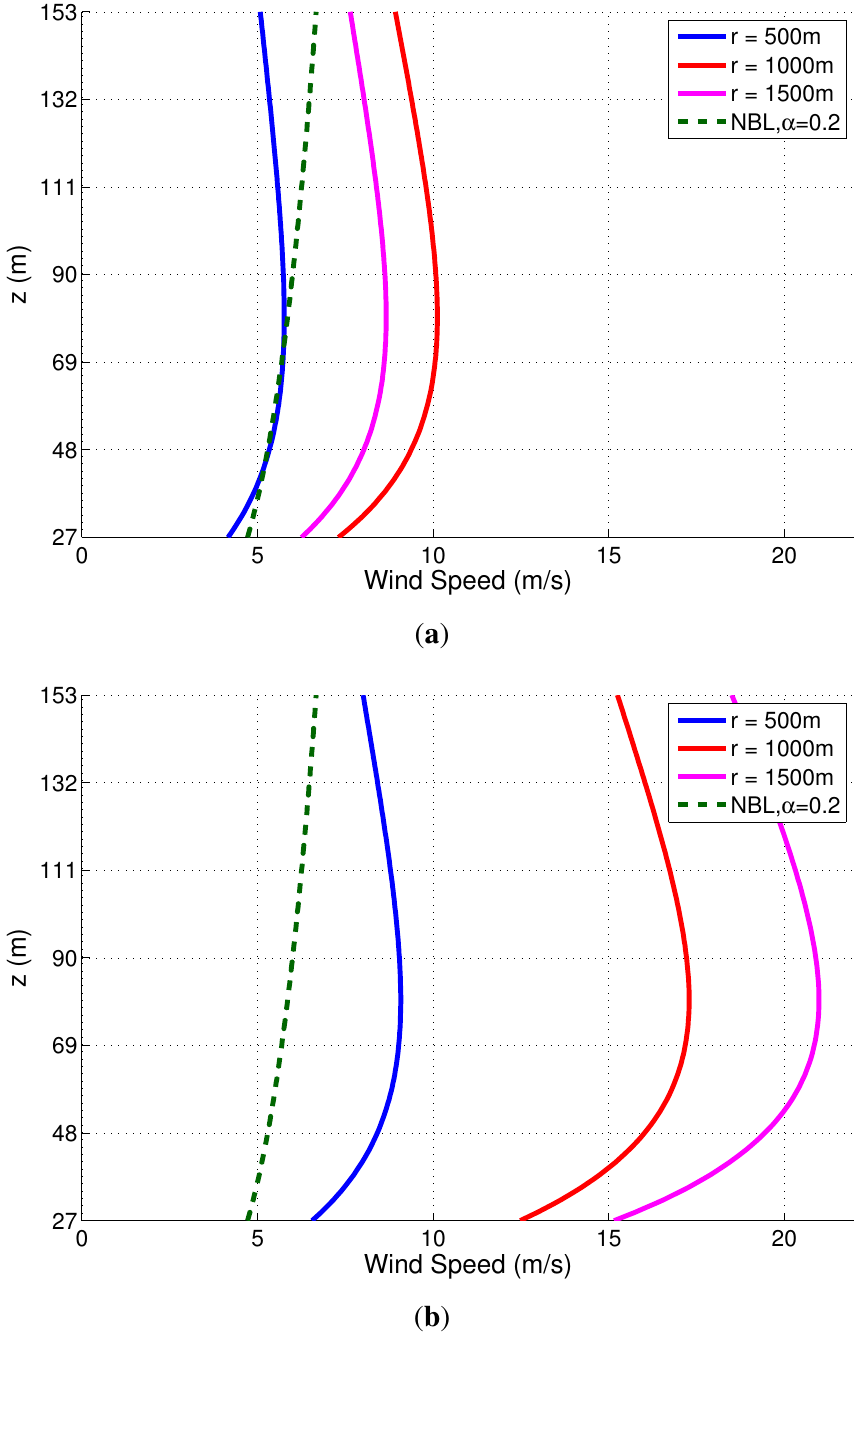
Figure 5. JAWS “Average” non-turbulent radial wind velocity profiles during the downburst. ( a ) Non-turbulent radial wind velocity profiles at t = t Π( t ) = 0 . 5 ; ( b ) Non-turbulent radial wind velocity profiles at t = t intensity, Π( t ) = 1 . 0